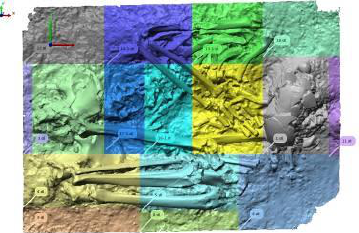
Figure 10. Output planning of burial zones.